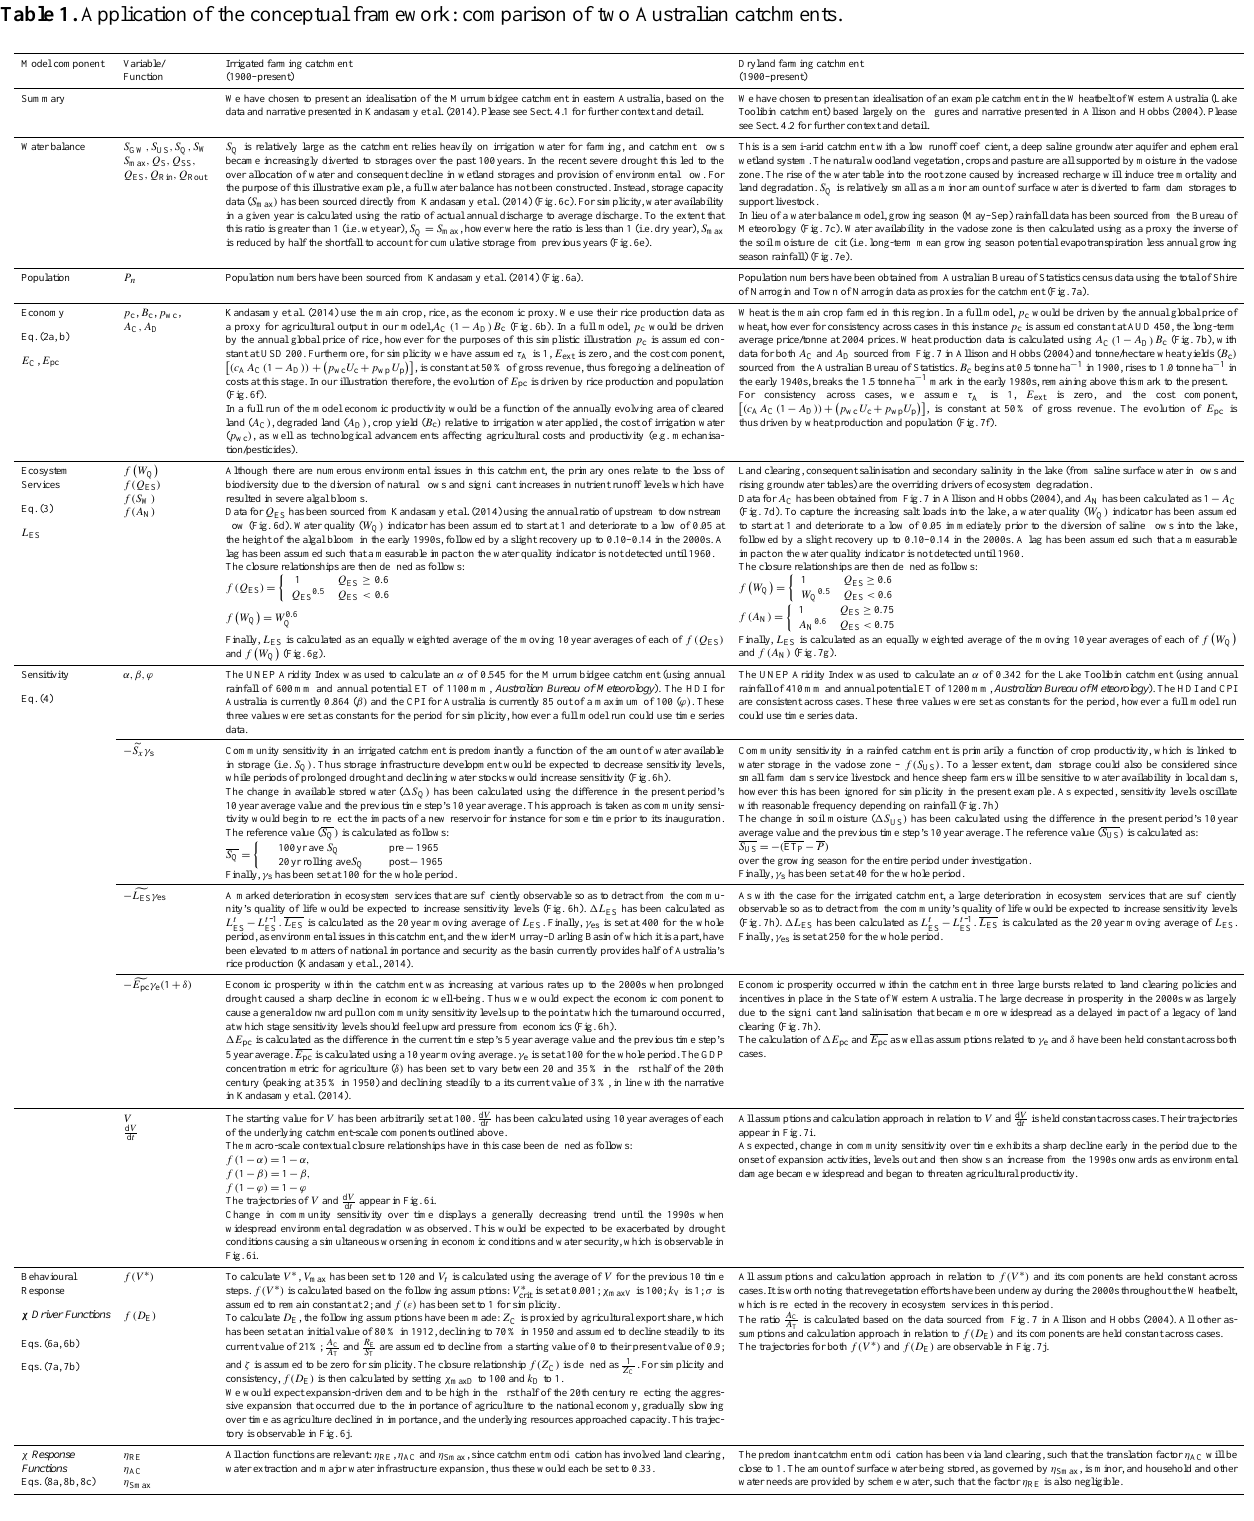
Table 1. Application of the conceptual framework: comparison of two Australian